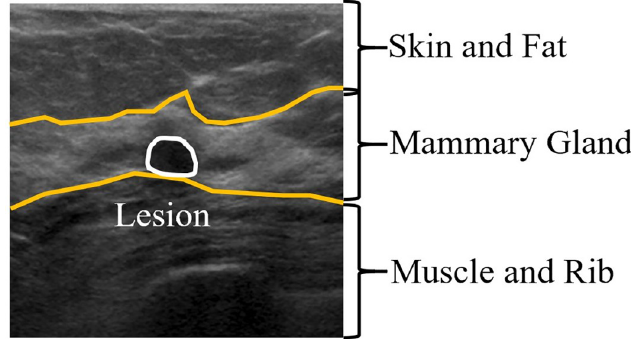
Fig 1. Schematic of the anatomical structure of a breast ultrasound (BUS)